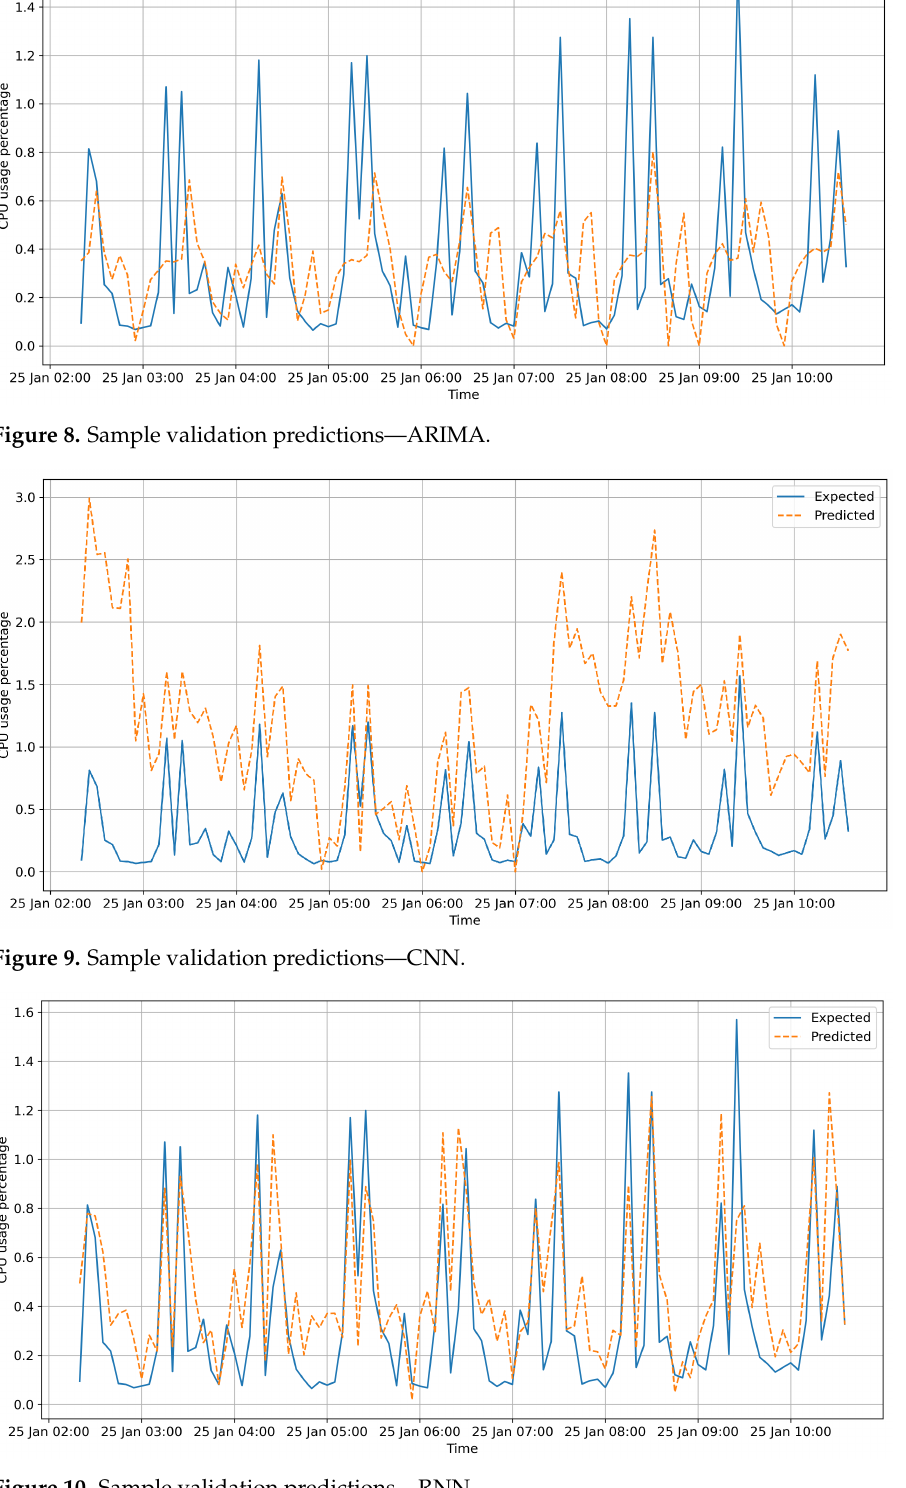
Figure 10. Sample validation